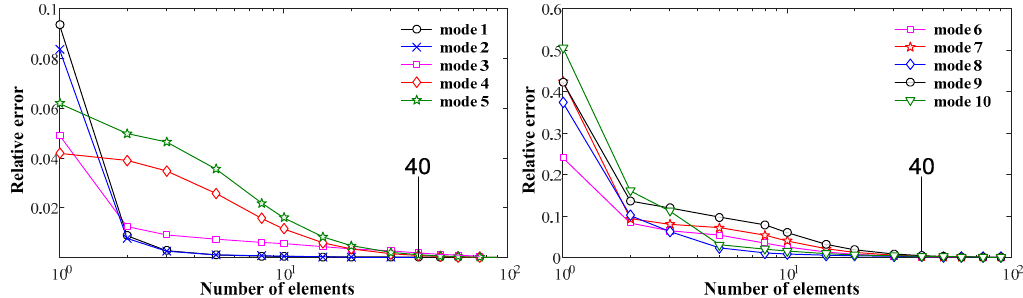
Figure 10. Convergence of the first ten natural frequencies of the cantilevered thin-walled structure, varying with the number of employed finite elements.